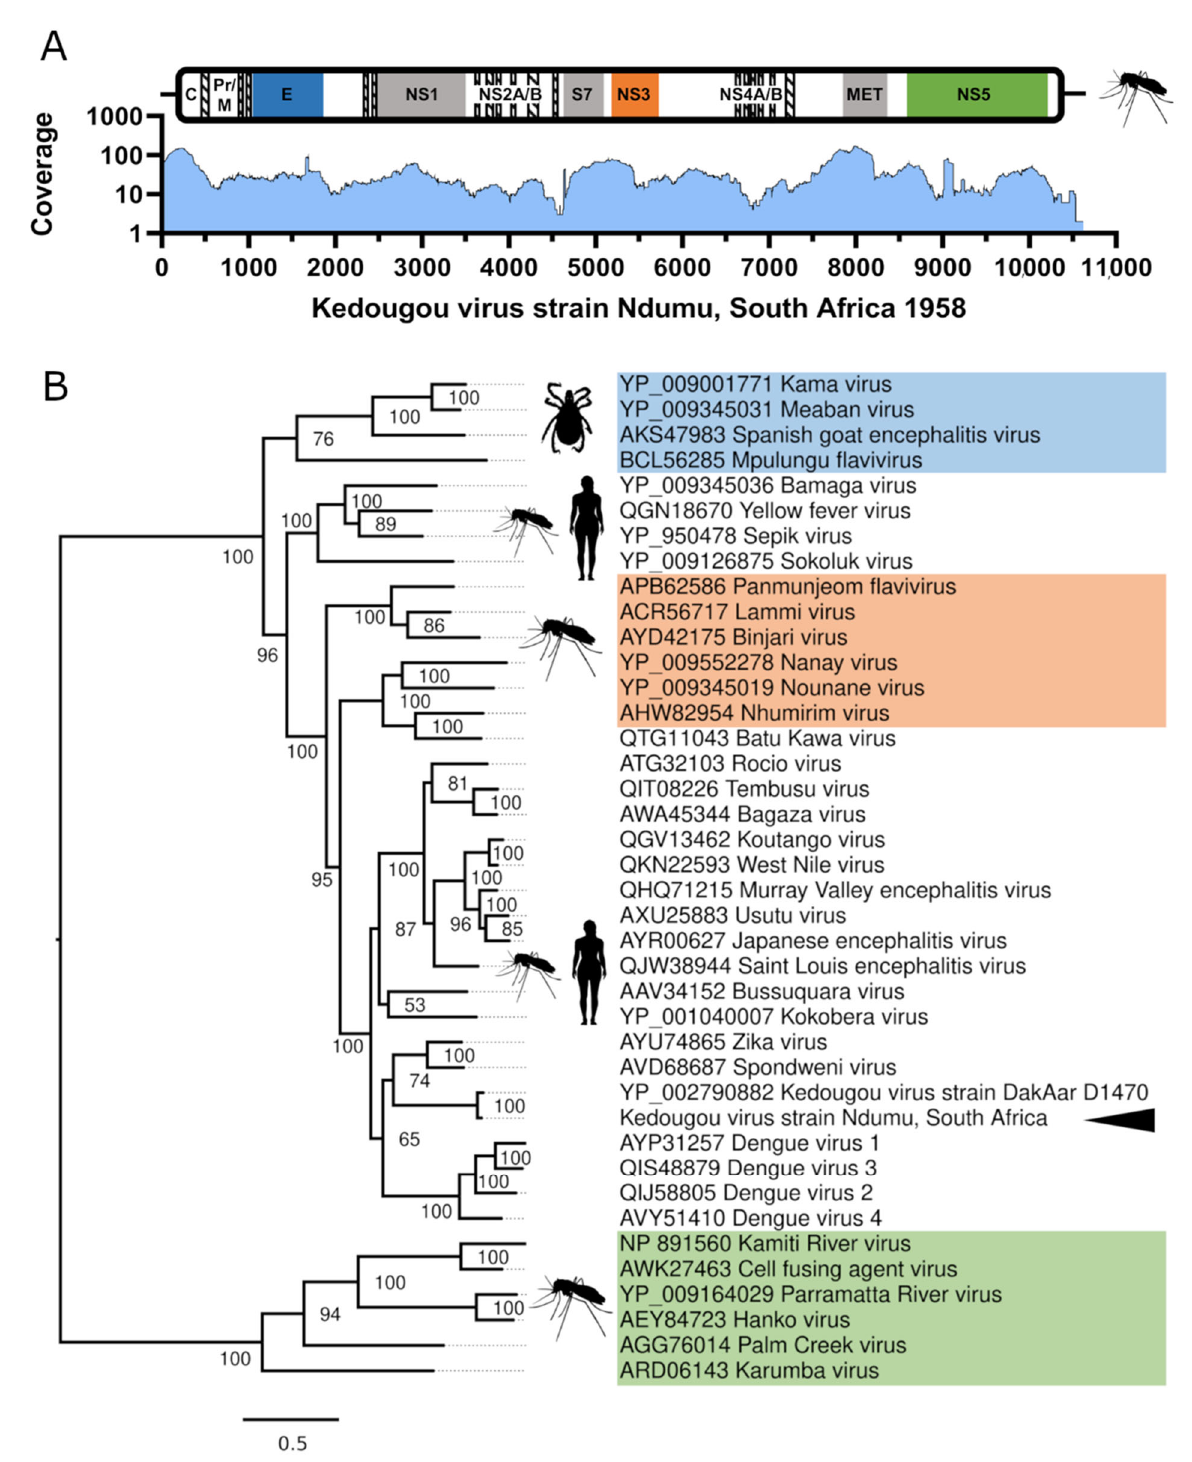
Figure 1. Genome coverage and phylogenetic position of the Kedougou virus isolate (Ndumu, South Africa). ( A ) Genome schematic showing protein domains as colored boxes, C; capsid, prM; pre-membrane, E; Flavivirus envelope glycoprotein, NS; non-structural proteins, pr; flavivirus propeptide, M; flavivirus envelope glycoprotein M; S7; flavivirus NS3 serine peptidase S7, MET; FtsJ-like methyltransferase. Coverage was obtained using samtools depth and plotted using Graphpad Prism (v9.0). ( B ) Consensus maximum-likelihood tree of representatives of the Flavivirus genus constructed using IQ-TREE v2.1.2 and the LG+F+R6 amino acid substitution model with 1000 bootstraps. The insect only classical insect flavivirus clade is indicated in green, tick flavivirus clade is indicated in blue and lineage two insect only clade shown in orange. The AR1071 Ndumu Kedougou virus isolate is marked with the